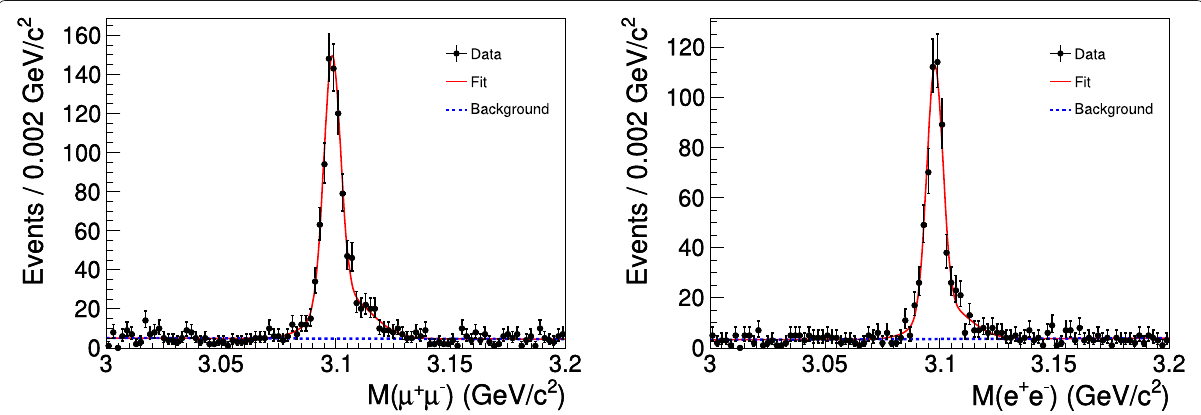
Fig. 5 The M (μ + μ − ) (left) and M ( e + e − ) (right) invariant mass distributions from selected Y ( 4260 ) → π + π − J /ψ events at BESIII